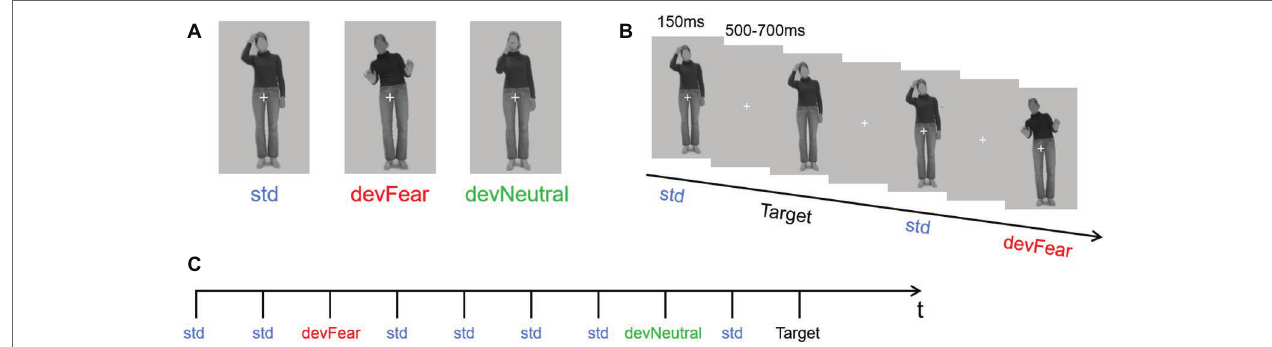
FIGURE 1 | (A) shows the three types of stimuli (neutral standard: std; emotional deviant: devFear; and neutral deviant: devNeutral). (B) is a task schematic of the oddball sequence. (C) shows the time course of the stimulus presented for 150 ms, followed by the cross on a gray screen displayed for 500–700 ms; SOA = 650–850 ms, and a target stimulus (neutral standard without cross, participants need to press the “k” button when it appears). (Statement: the stimuli used in the picture has been approved for publication by the